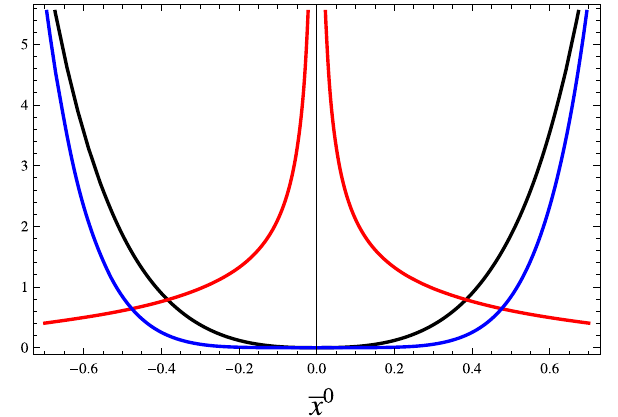
Fig. 1 Qualitative behavior of the scale factor a (black), the speed of light c (red) and the gravitational constant G (blue) before ( ¯ x 0 < 0) and after ( ¯ x 0 > 0) the curvature singularity plotted with the help of solution given by (10), (11) and